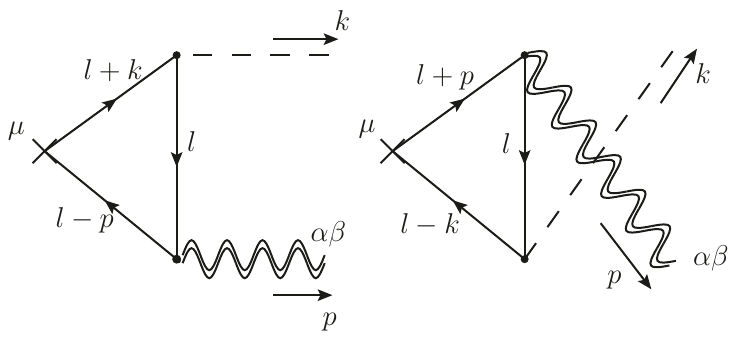
Figure 5 . Two-vertex gravitational corrections to the one-axion contribution to the